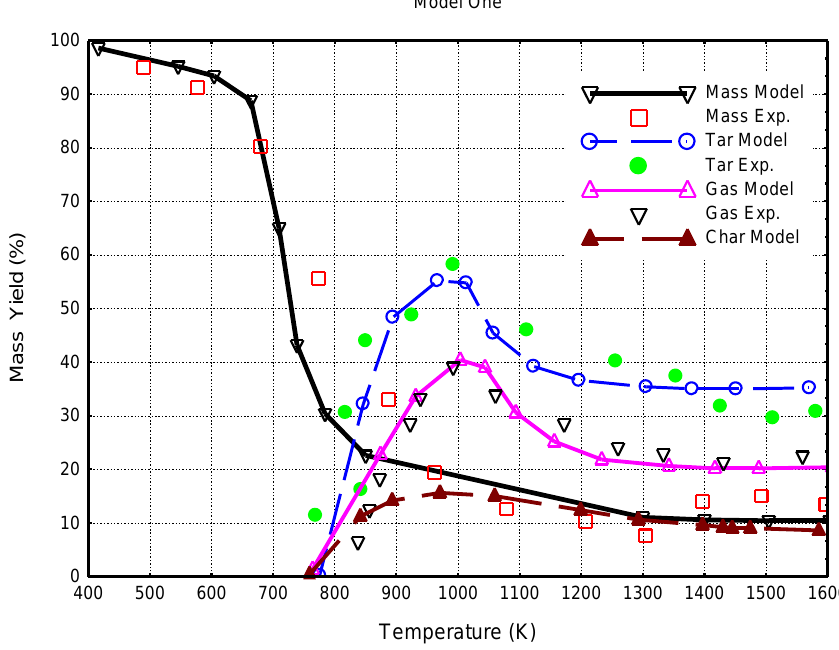
Figure 3. Simulations of gasification and/or devolatilization model 1 (M1) and experimental measurements (using Nunn et al. [50]) for a mass yield of gases, char, and tar of powder biomass at fast heating rate conditions in combustion engines. Processes 2020 , 6 , x FOR PEER REVIEW